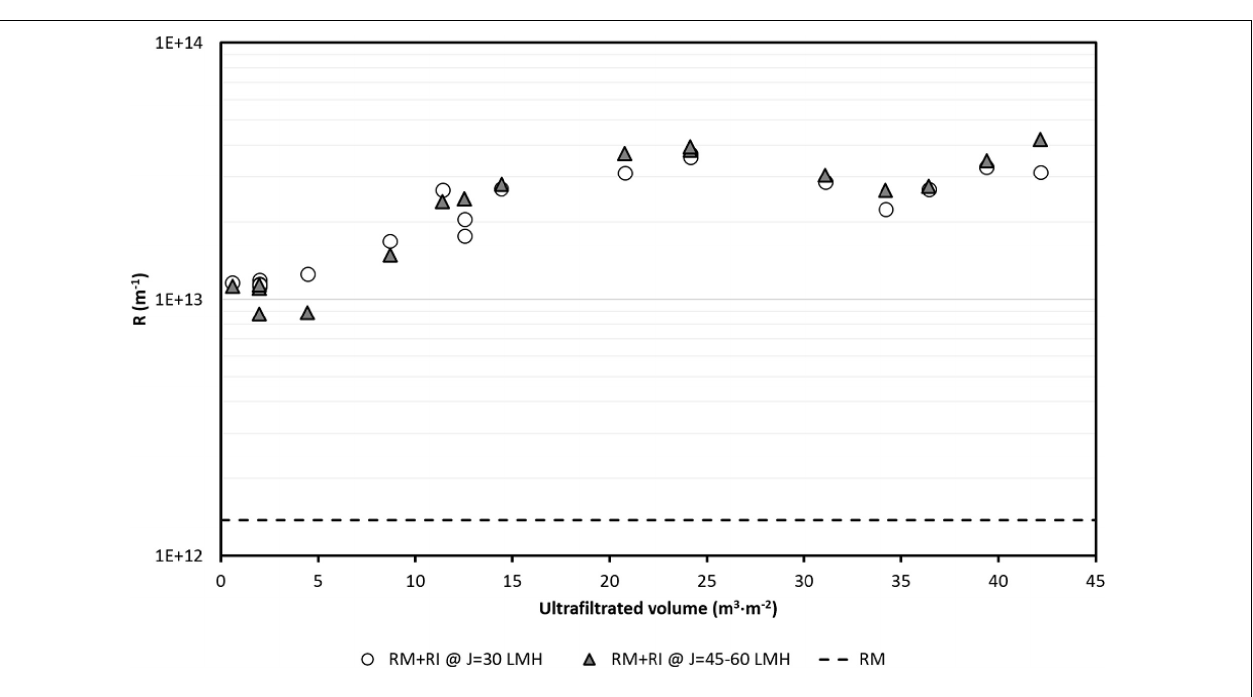
FIGURE 9 | Evolution of filtration resistance (R M + R I ) measured after CIP